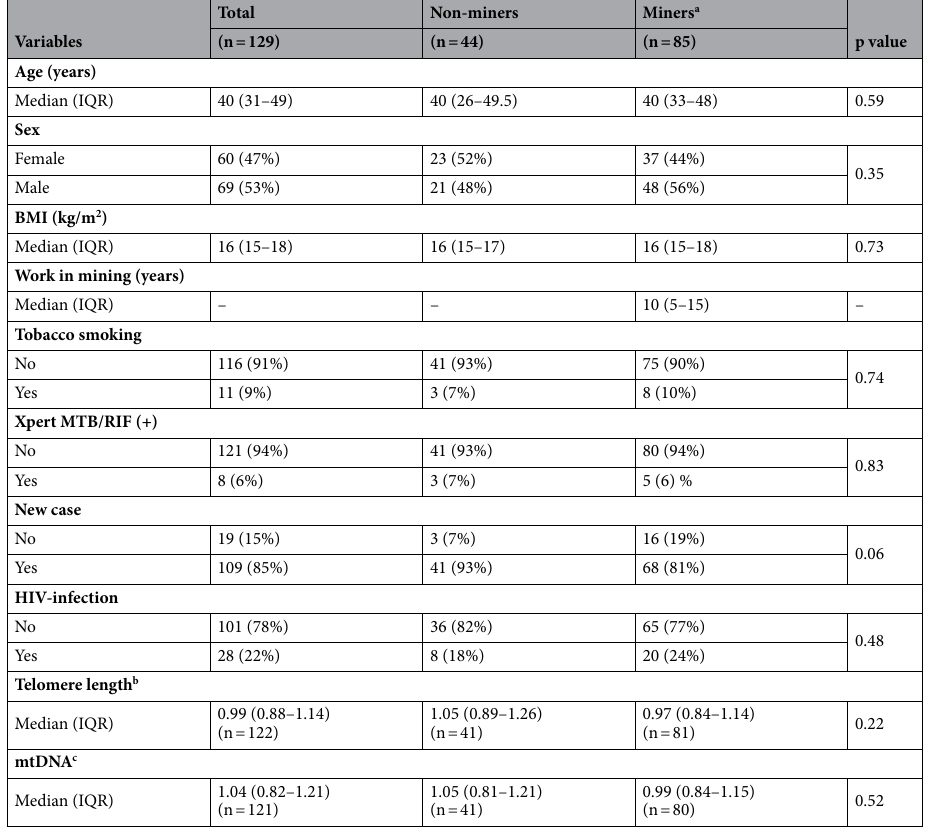
Table 1. Baseline characteristics of 129 PTB patients working or living around artisanal mining of gold in Eastern DR Congo. Data are shown as n (%) otherwise as median and interquartile range (IQR). BMI body mass index, Xpert MTB/RIF automated diagnostic test for rapid identification of Mycobacterium tuberculosis DNA and resistance to rifampicin (RIF). a Miners are defined as participants reporting current or